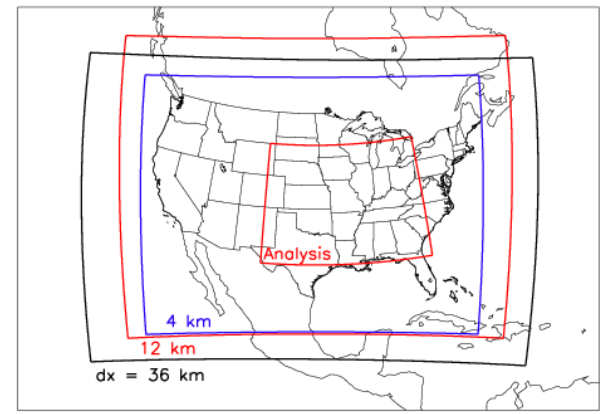
Fig. 1. Non-nested domains for WRF simulations and region for analysis. figure